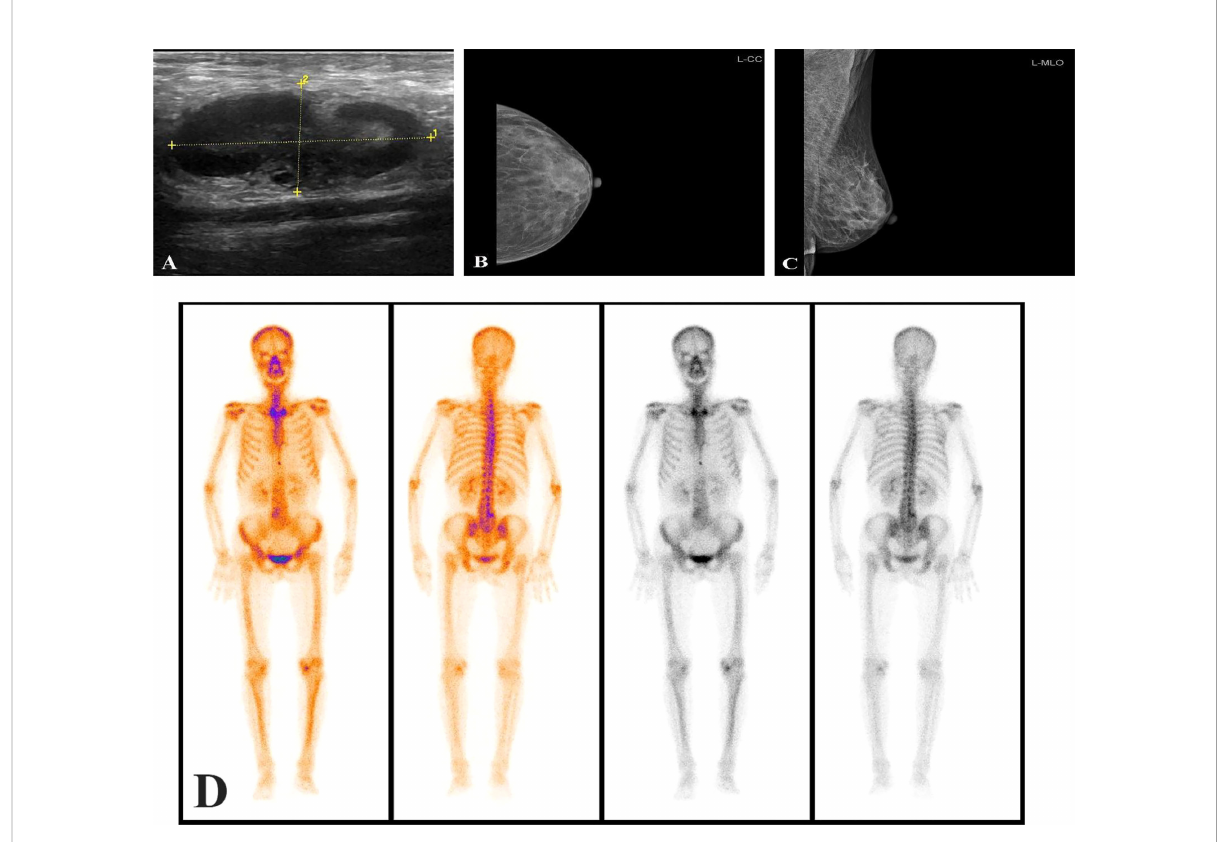
FIGURE 3 Axillary ultrasound showed enlarged axillary lymph nodes (A) ; The mammary gland molybdenum target X-ray was not found obvious breast mass (B, C) ; No obvious mass was found in whole-body bone scintigraphy (D)